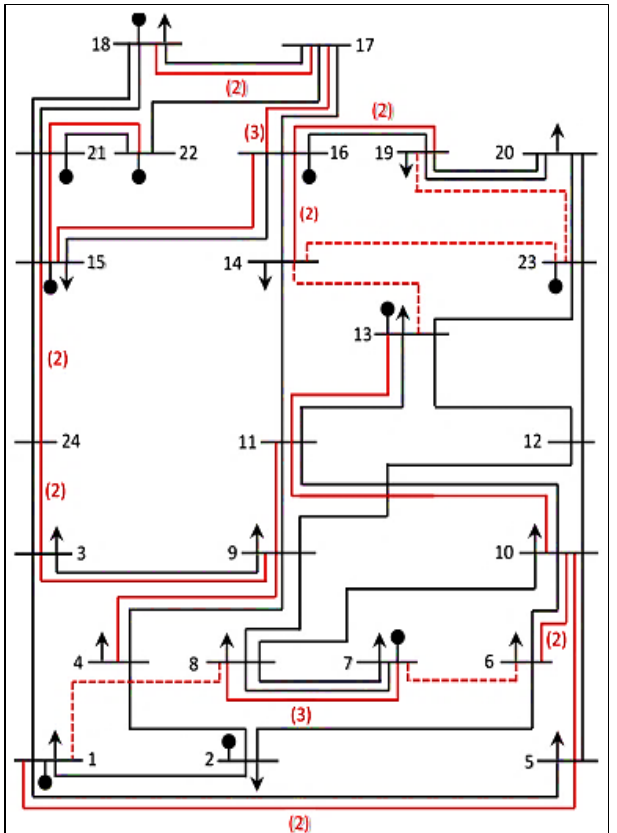
Figure 6: IEEE-24/41 system – Planned network. Source: Authors, (2021).